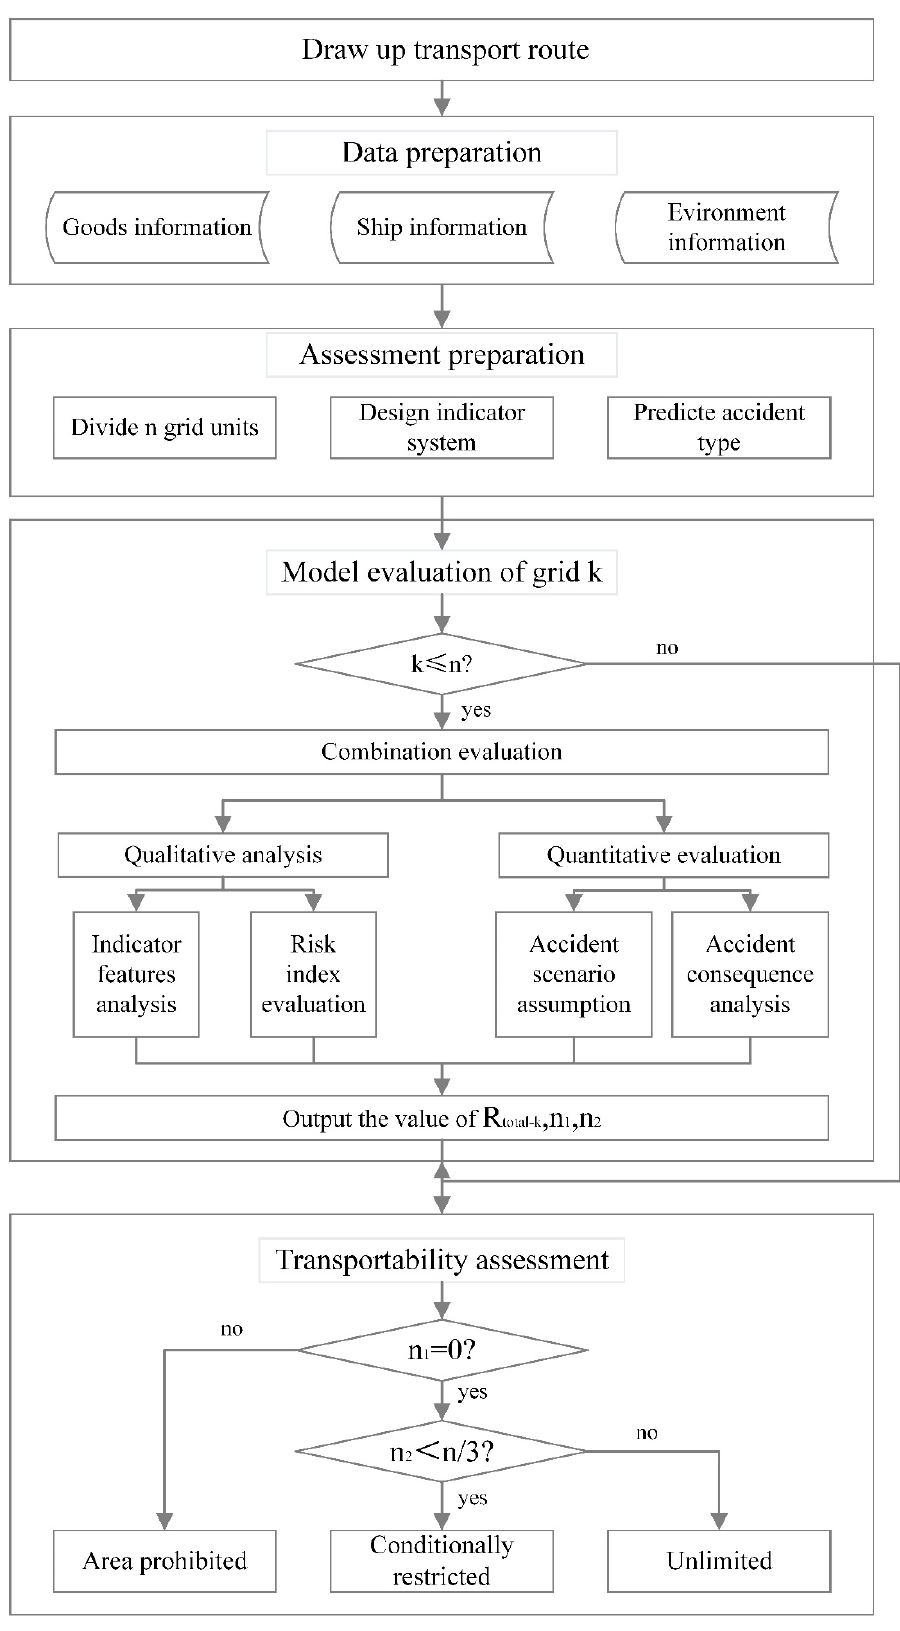
Figure 7. Process of transportability assessment framework.